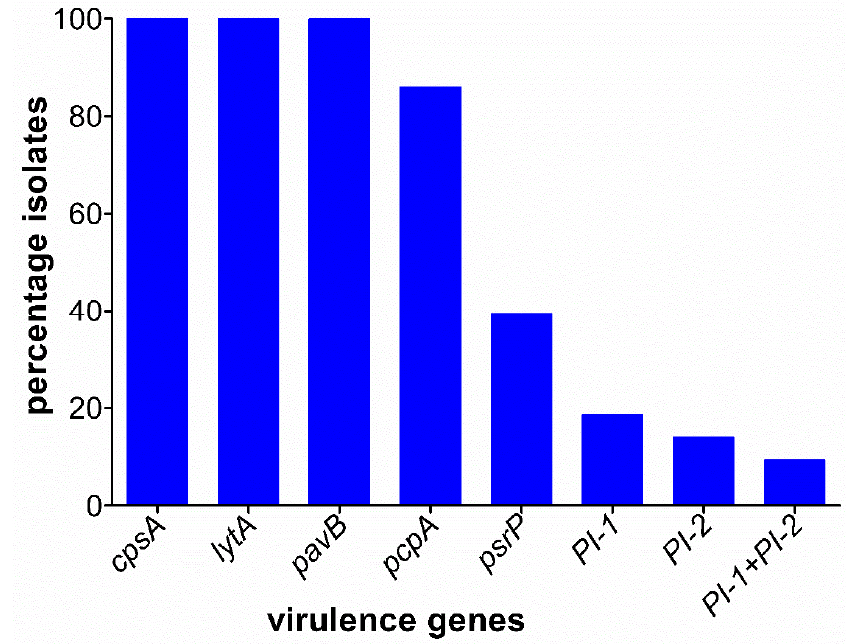
Figure 1. Prevalence of virulence genes among 43 MDR pneumococcal isolates.